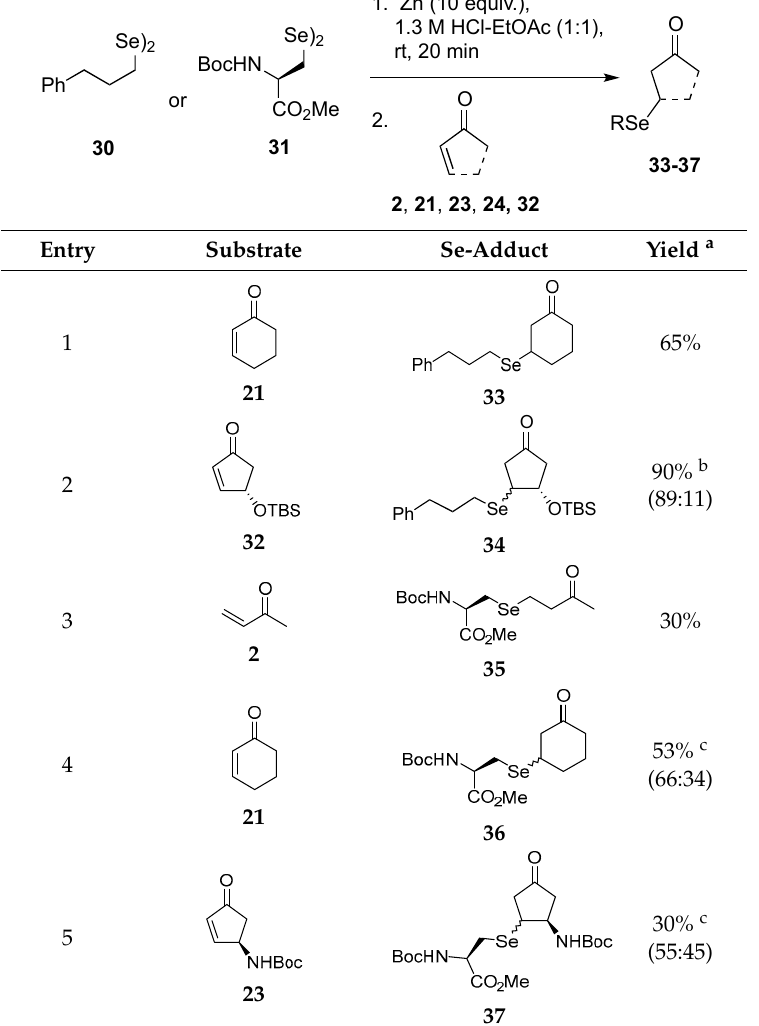
Table 3. Reaction of 1,2-bis(3-phenylpropyl)diselenide 30 and protected selenocystine 31 with enones.